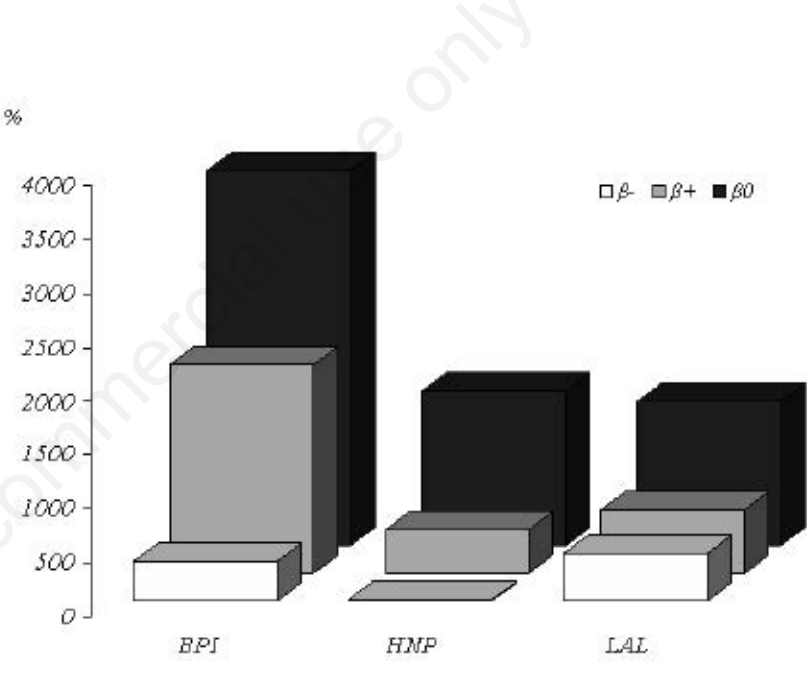
Figure 1. Dynamics of changes in antimicrobial peptides in